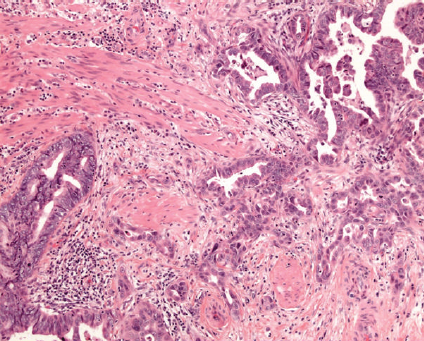
Figure 1: Adenocarcinoma invading muscularis, H and E, 100x.